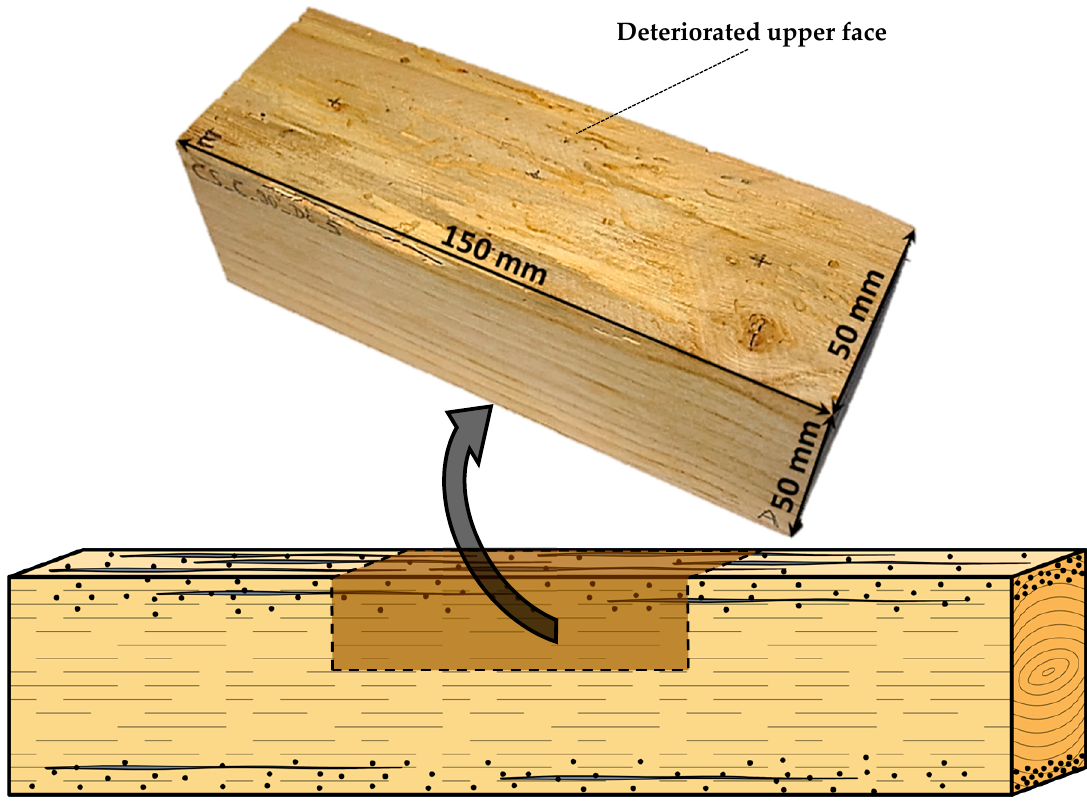
Figure 2. Geometry of the small timber samples extracted from existing beams infested by anobiids.